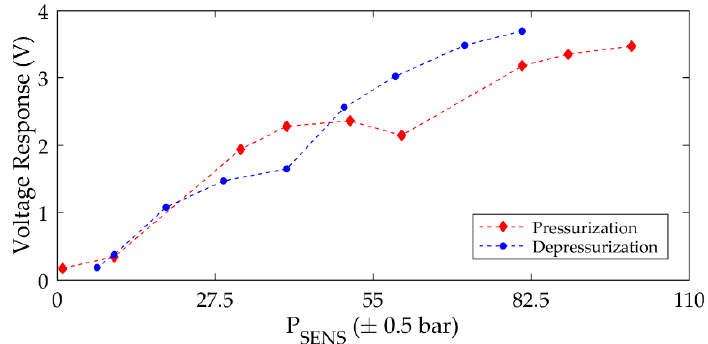
Figure 9. The hysteresis associated with the voltage response as a function of air pressure level for the CFUT as the T X transducer and VFUT 2 as the R X transducer. Note the (peak-to-peak) voltage response in each case is extracted from the first peak in the A-scan.